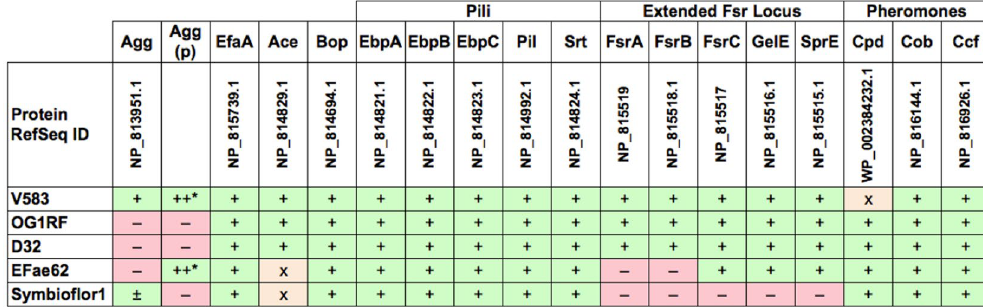
Figure 2. Comparative genomics screen for the 17 biofilm-associated protein-coding genes. Comparative genomics in a tabular format, representing patterns of gene presence and absence, analyzed by blastX against the 17 biofilm-related proteins and confirmed by blastN against primer pairs, in five representative E. faecalis strains. + : orthologous gene present; ± : paralogous gene present; − : gene absent; X: pseudogene. For Agg, more than one paralogous gene have been identified in some genomes. We differentiate the chromosomal and plasmid (p) copy of these